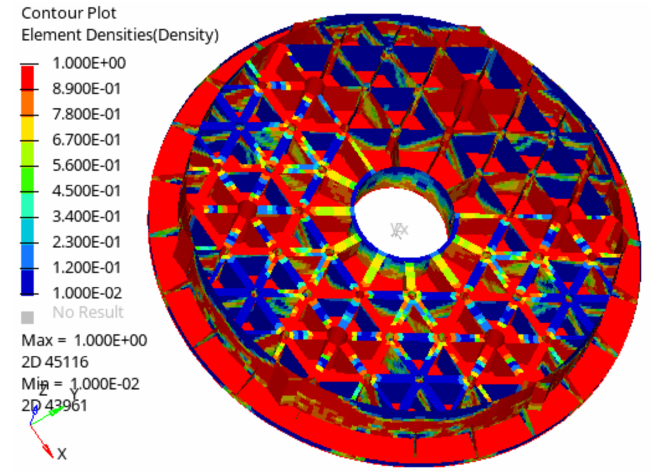
Figure 4. Material distribution result of the topology optimization.